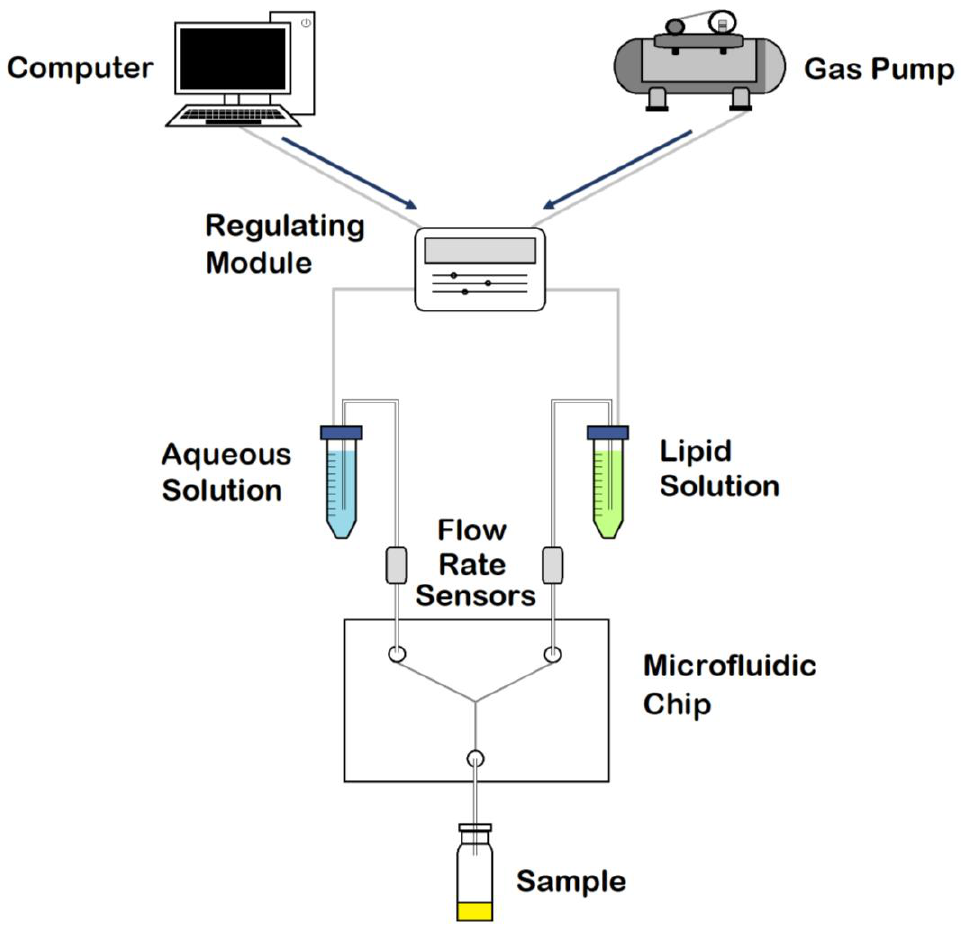
Figure 2. Schematic representation of the components in a microfluidic system. Adapted with permission from Weaver et al. [19].